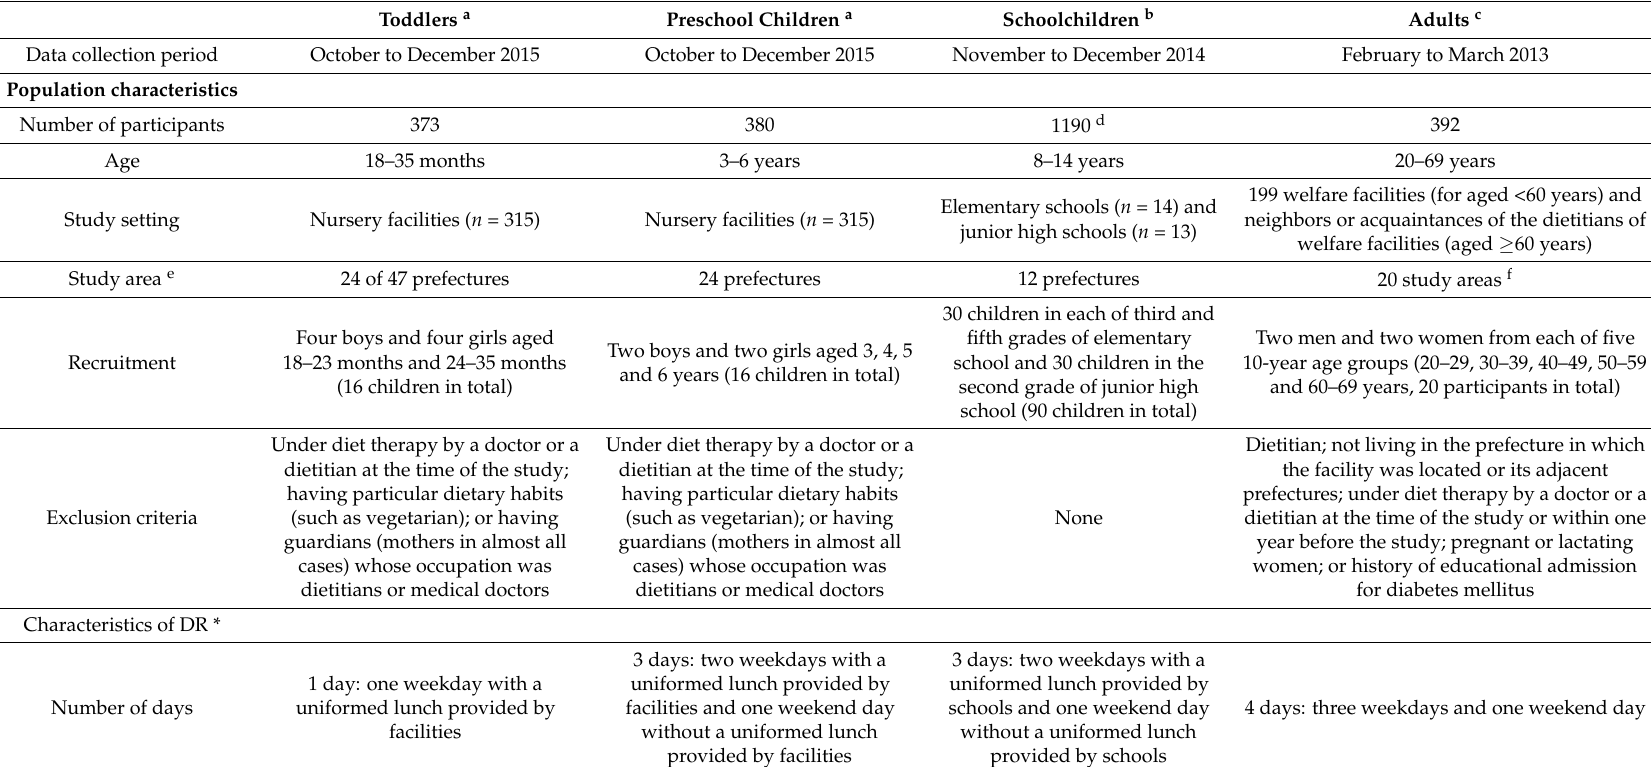
Table 1. Description of dietary